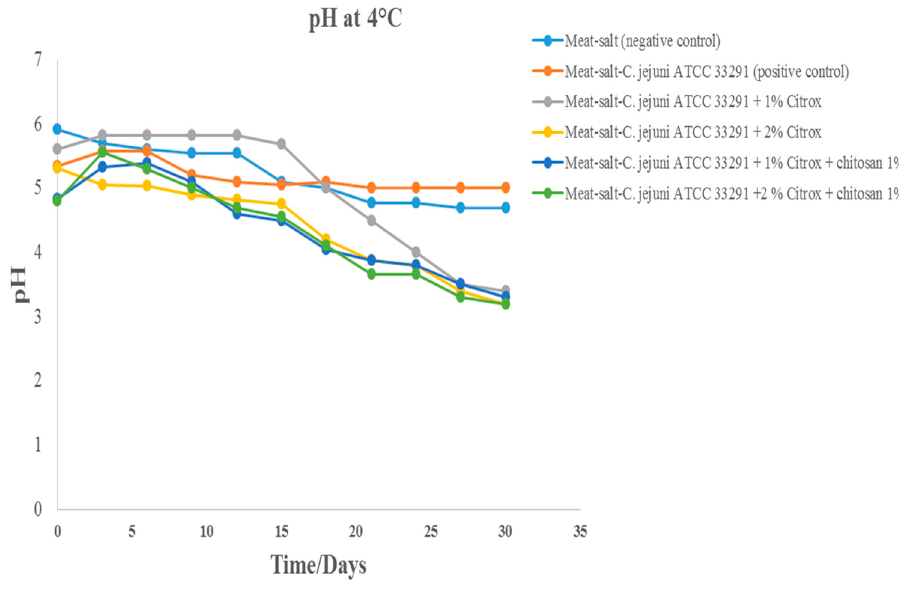
Figure 6. pH values of camel meat stored at 4 °C for 30 days.